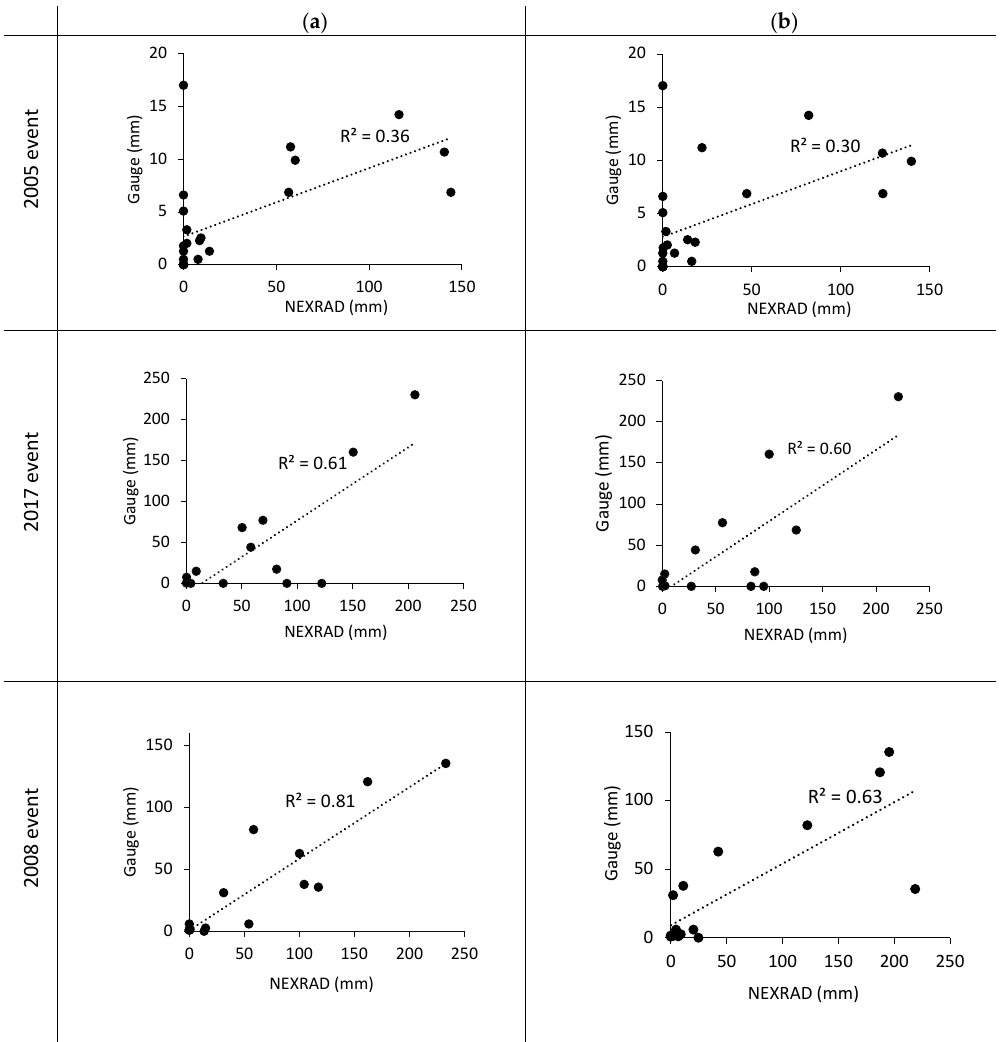
Figure 9. Scatter plots of hourly NEXRAD and gauge rainfall data of the flood events for ( a ) Upper Blue and ( b ) Indian